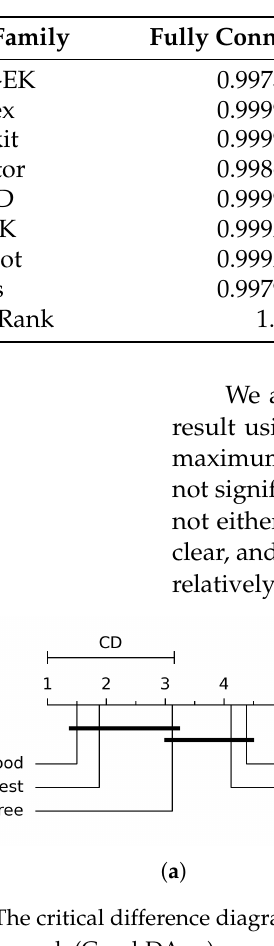
Table 4. AUC values for each classifiers using traffic interaction graph (GraphDApp) with average rank.